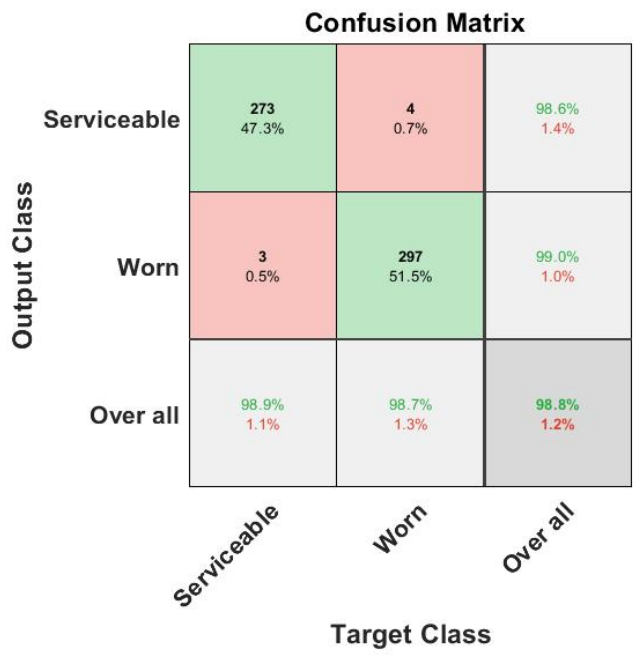
Figure 5. Confusion matrix.